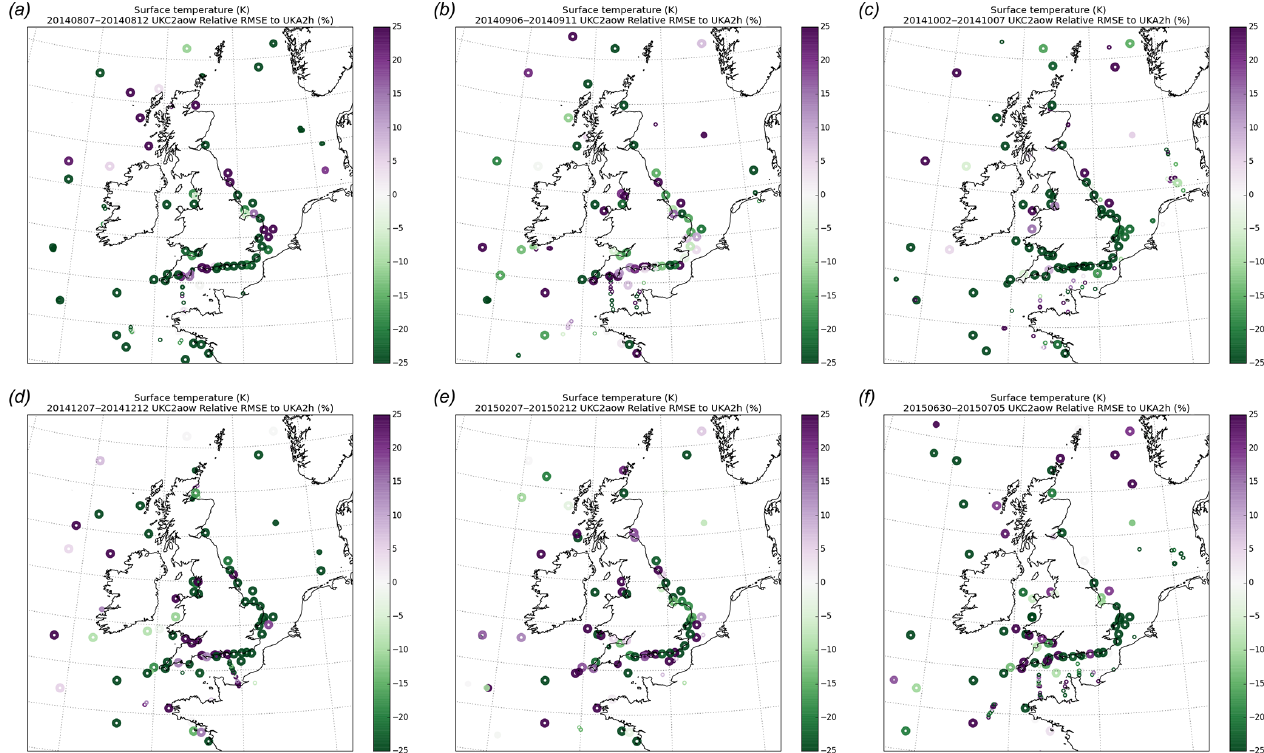
Figure 6. Differences in case study atmosphere model RMSE statistics for sea surface temperature, comparing statistics computed for the fully coupled UKC2aow simulation as a % difference relative to the atmosphere-only UKA2h runs in which the initial SST is persisted. Green sites indicate an overall reduction in RMSE relative to the control. Results are shown for 5-day case study periods in (a) August 2014, (b) September 2014, (c) October 2014, (d) December 2014, (e) February 2015 and (f) July 2015. RMSE statistics are computed comparing UKC2aow and UKA2h model outputs with in situ observations. Note that only an inner section of the domain is presented for